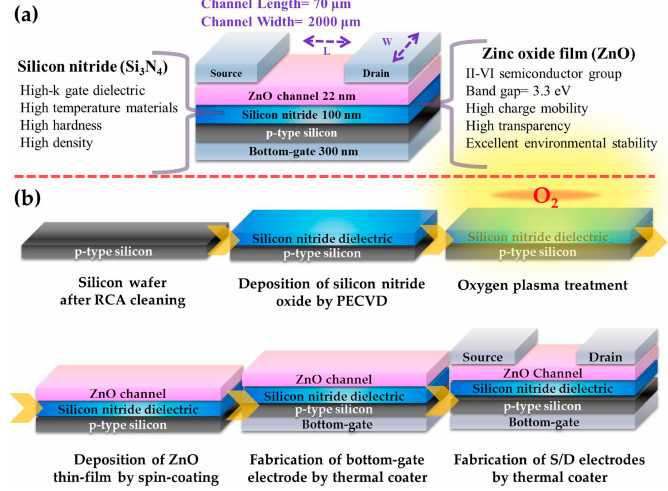
Figure 1. Zinc oxide (ZnO) based thin-film transistor (TFT) and its fabrication process. ( a ) Schematic diagram and illustration of ZnO-based TFT. For the TFT sensing, the ZnO film between two electrodes (source and drain electrodes, S/D) are exposed to various liquid solvents; ( b ) The fabrication procedure of a ZnO-based TFT by a low-temperature